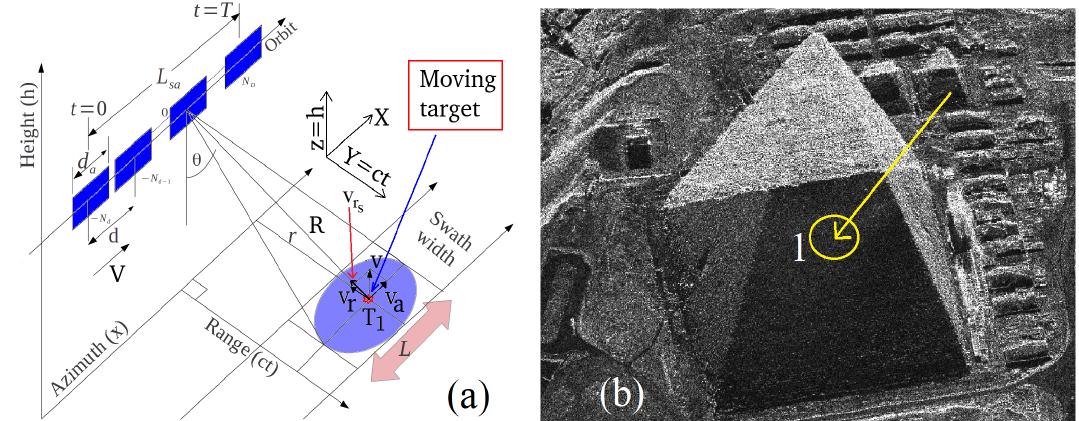
Figure 3. ( a ): SAR acquisition geometry. ( b ): SAR image in magnitude.